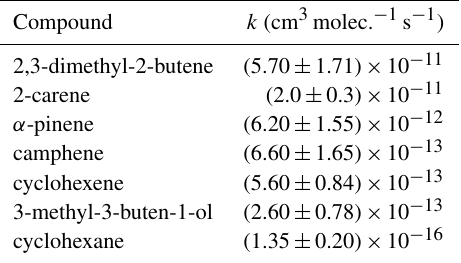
Table 2. Reference compounds used. Recommended rate coeffi- cients and uncertainties from McGillen et al.